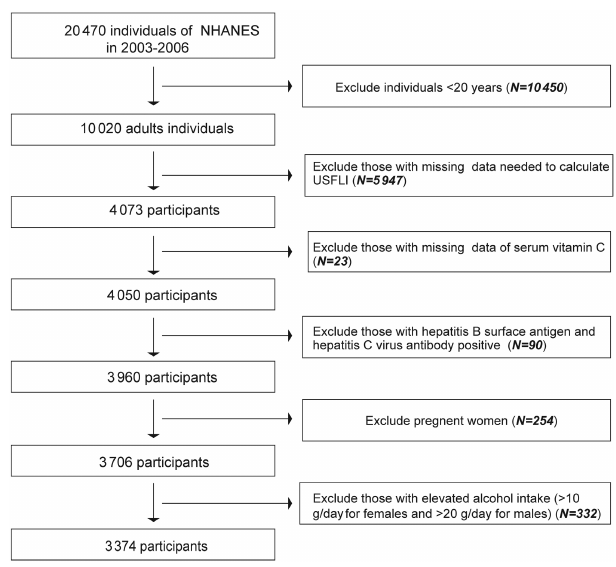
Figure 1. Flow chart of the